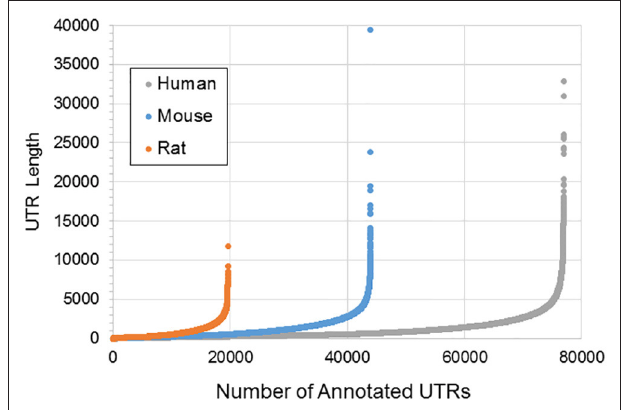
FIGURE 1 | Length and distribution of UTRs for human, mouse, and rat. Shown in the x-axis is the cumulative number of total UTRs. The y-axis for each point represents the longest annotated length from the stop codon for each Ensembl gene, with genes sorted from shortest to longest along the x-axis.